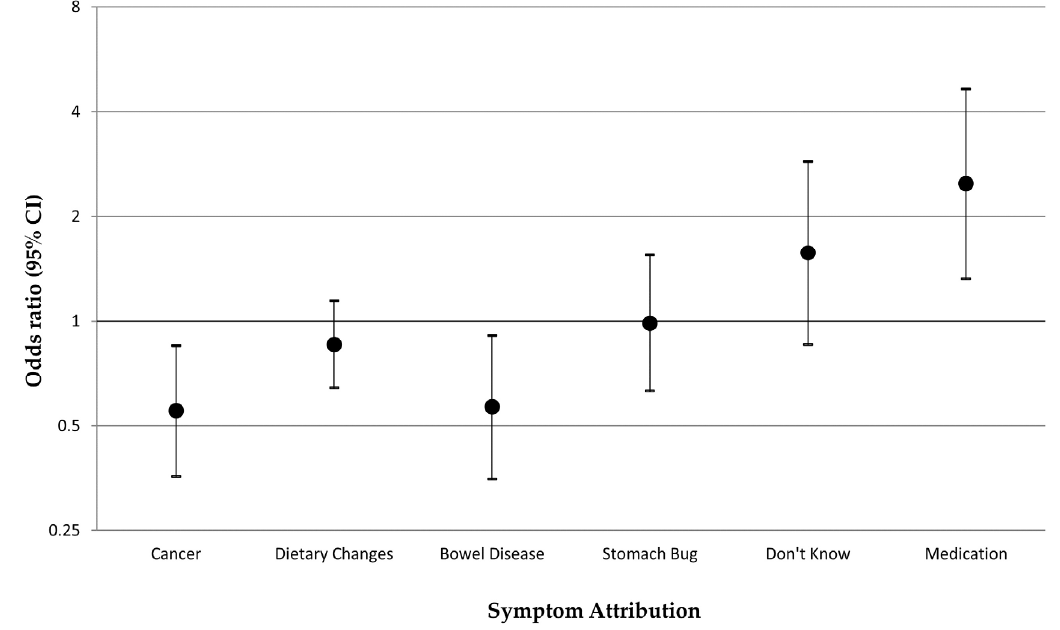
Figure 1. Symptom attributions reported by participants with diabetes versus those without when experiencing a change in bowel habits (vignette 2): multivariable logistic regression odds ratios, adjusted for age, sex, ethnicity, and comorbidity number. Note: Each symptom attribution was included as the outcome (binary yes/no outcome) in a separate multivariable model .